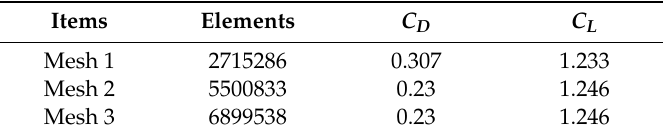
Table 1. Mesh Table 1. Mesh independence.